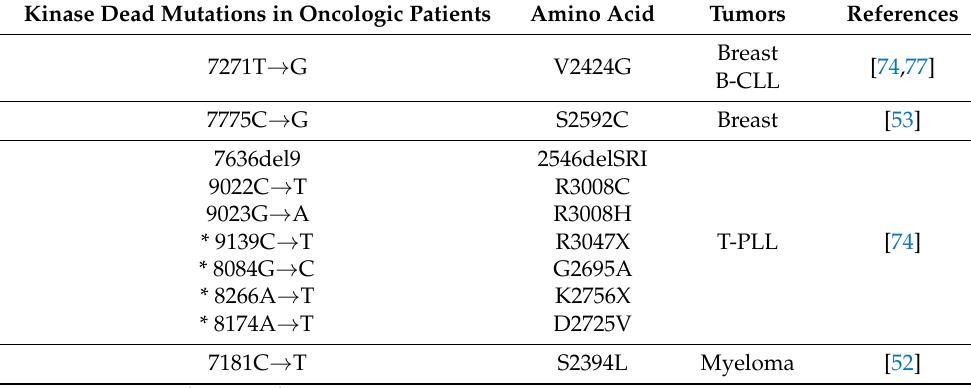
Table 4. List of common ATM kinase dead mutations identified in oncologic patients where ATM protein without kinase activity is expressed. Kinase Dead Mutations in Oncologic Patients Amino Acid